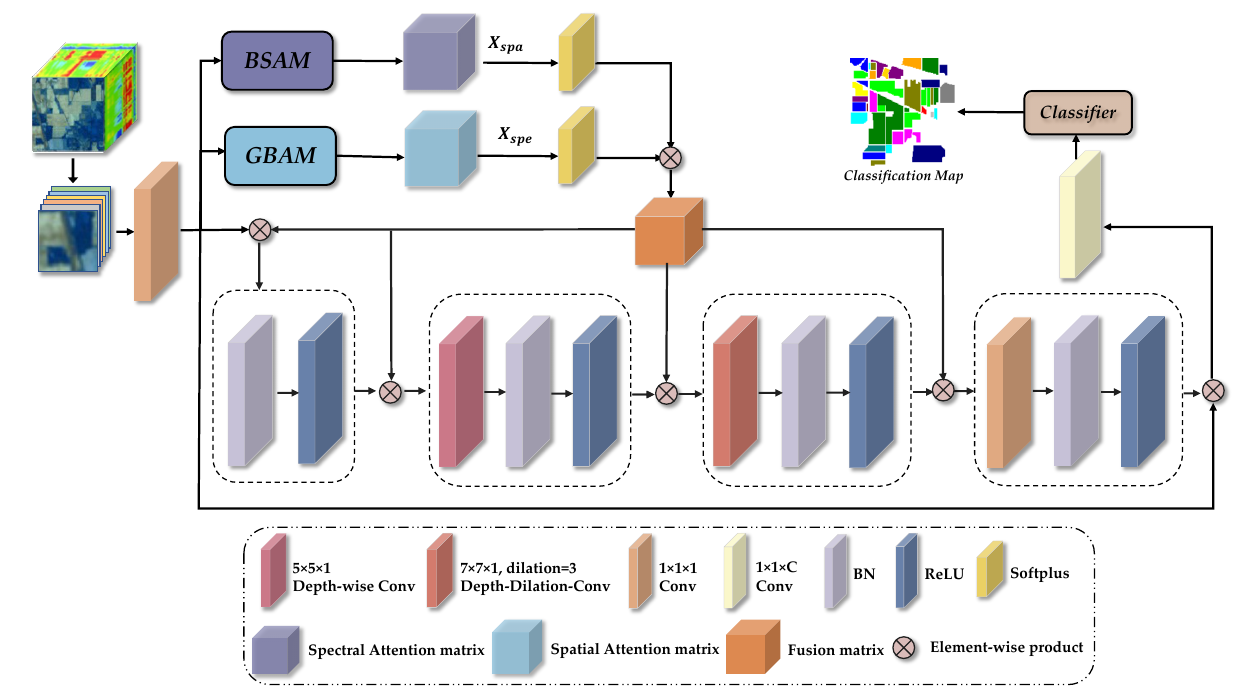
Figure 1. The overall architecture of the proposed AETF-Net model.